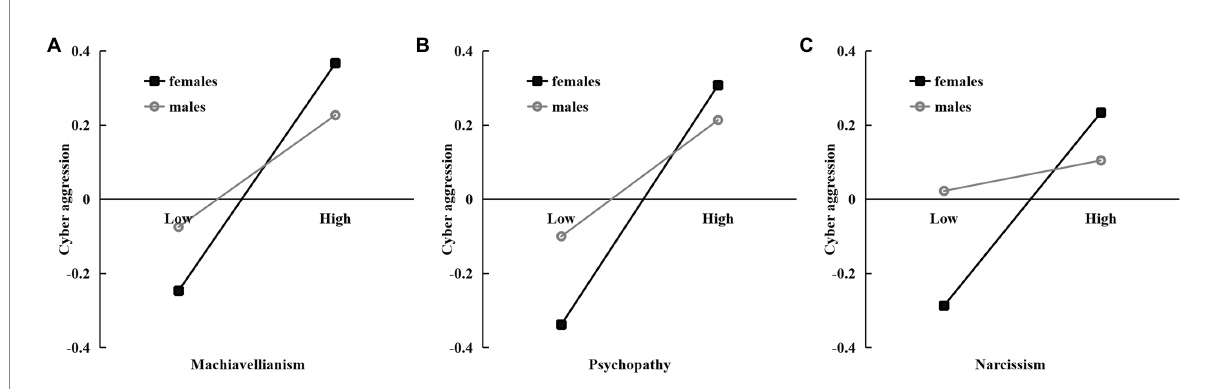
FIGURE 2 The moderating role of gender in the relation between dark triad personality, i.e., Machiavellianism (A) , psychopathy (B), and narcissism and cyber aggression (C)